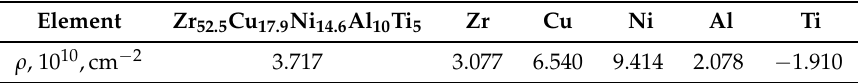
Table 4. The scattering densities of elements included in Zr 52.5 Cu 17.9 Ni 14.6 Al 10 Ti 5 .